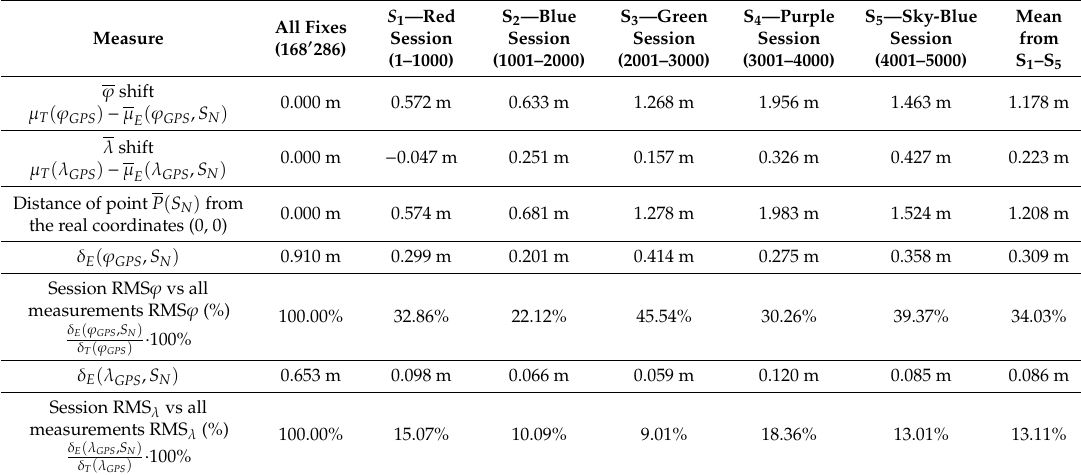
Table 3. Shift values in measurement results ( ϕ and λ ) and RMS values of five sessions of 1000 measurements each, compared to the whole population (168 (cid:48) 286 fixes) during the GPS measurement campaign in